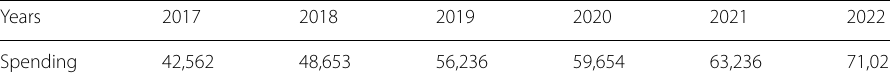
Table 3 Forecast of total domestic tourism expenditure from 2017 to 2022 Years